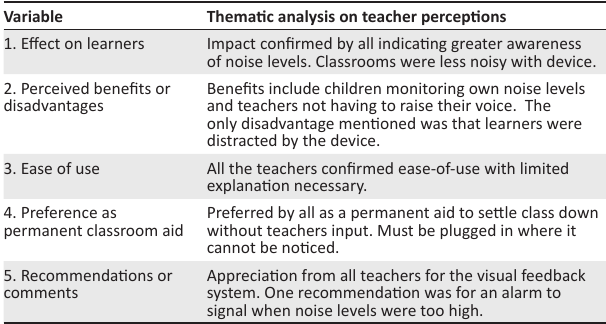
device ( n = 6). Variable